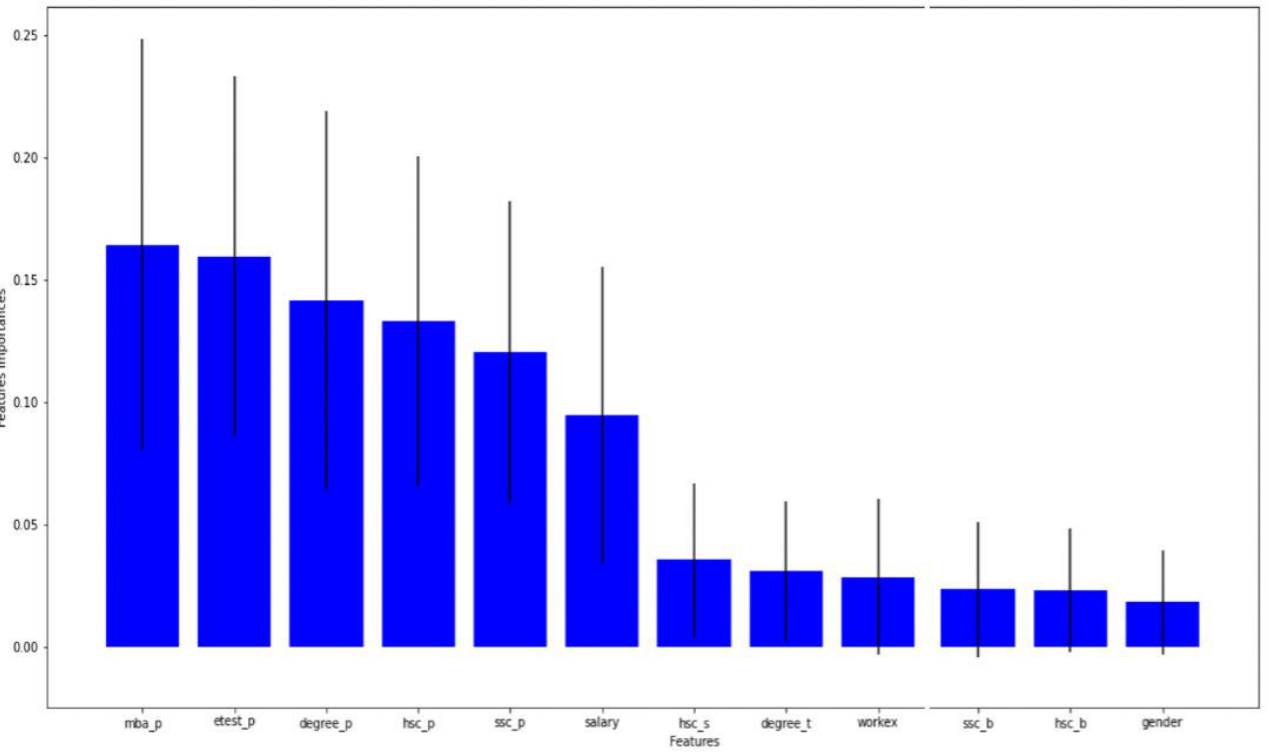
Figure 6. Input features importance chart.